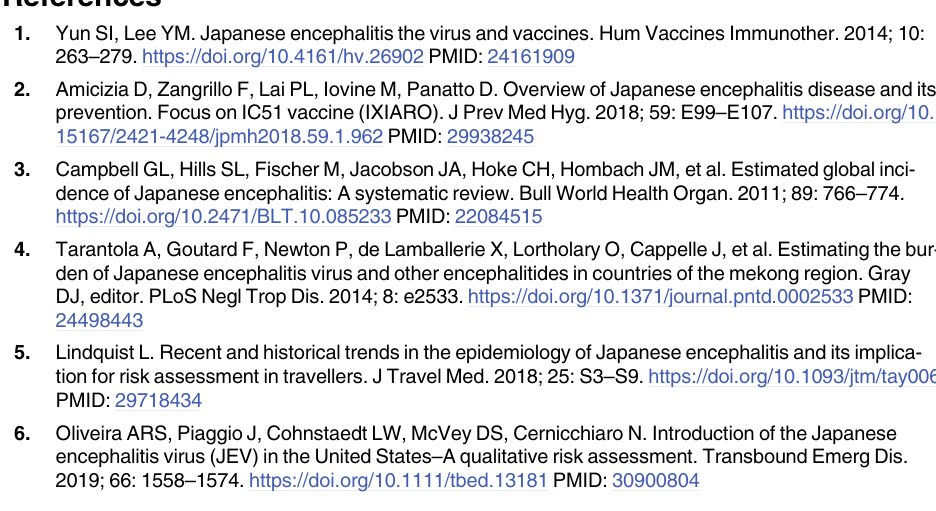
S1 Table. RNA-seq. S2 Table. Fetal